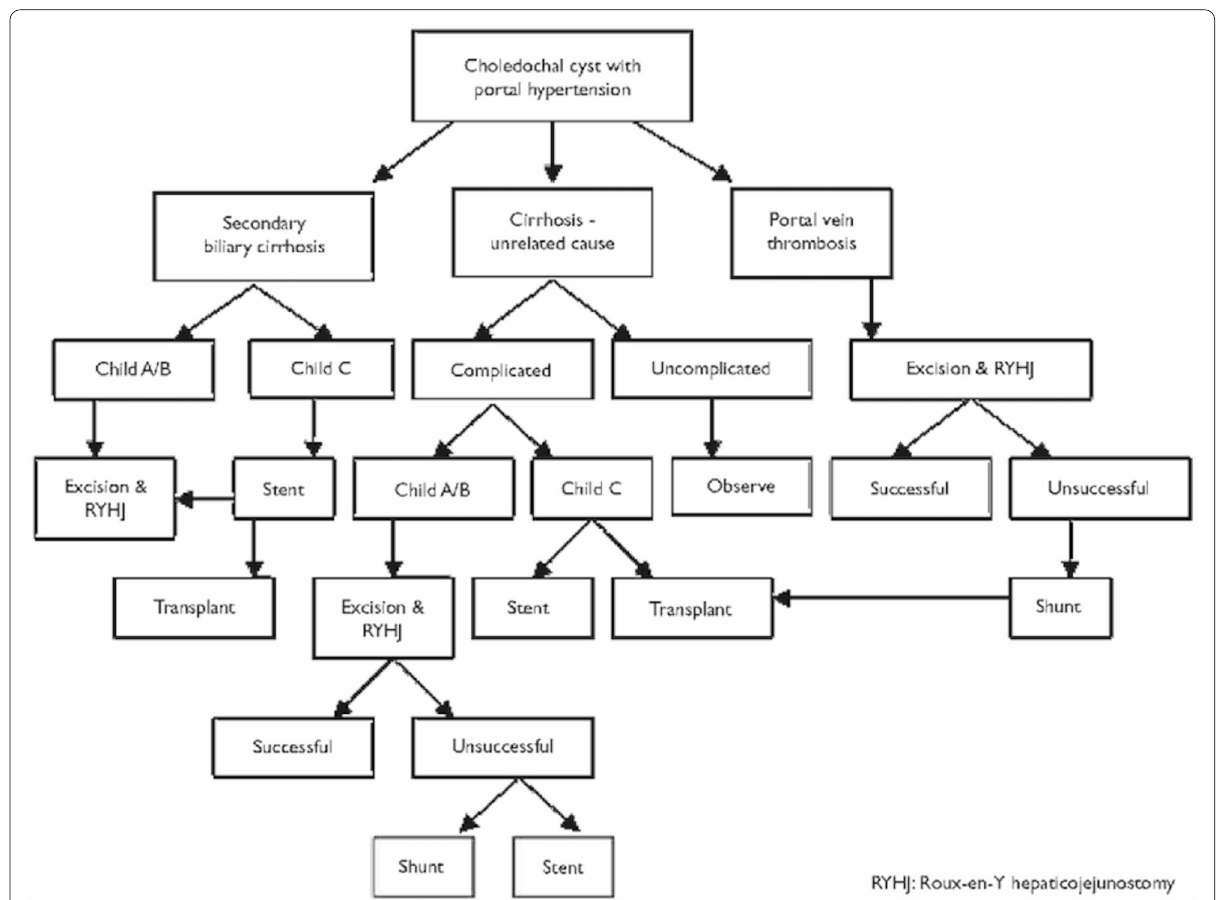
Fig. 4 Algorithm for management of choledochal cyst with portal hypertension. Saluja SS, Mishra PK, Sharma BC, Narang P. Management of choledochal cyst with portal hypertension. Singapore Med J. 2011; 52(12):